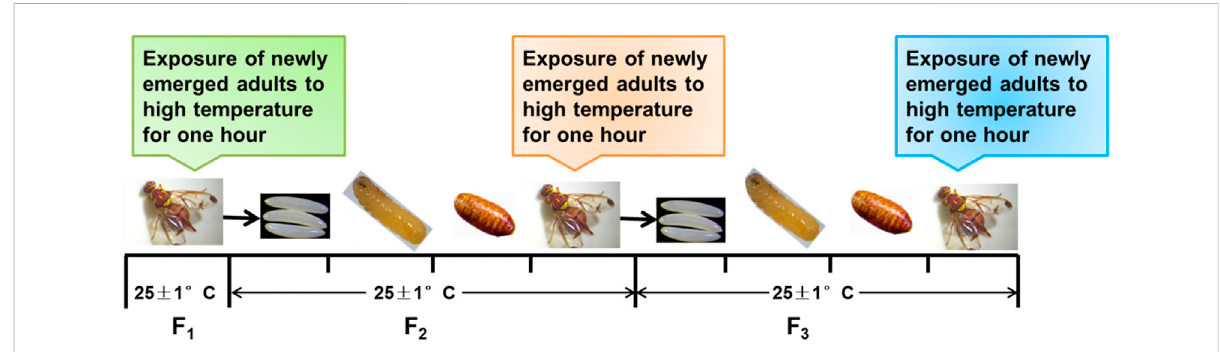
FIGURE 1 Setting of short-term high-temperature treatment. F 1 – F 3 of Z. cucurbitae (Coquillett) are exposed to short-term high